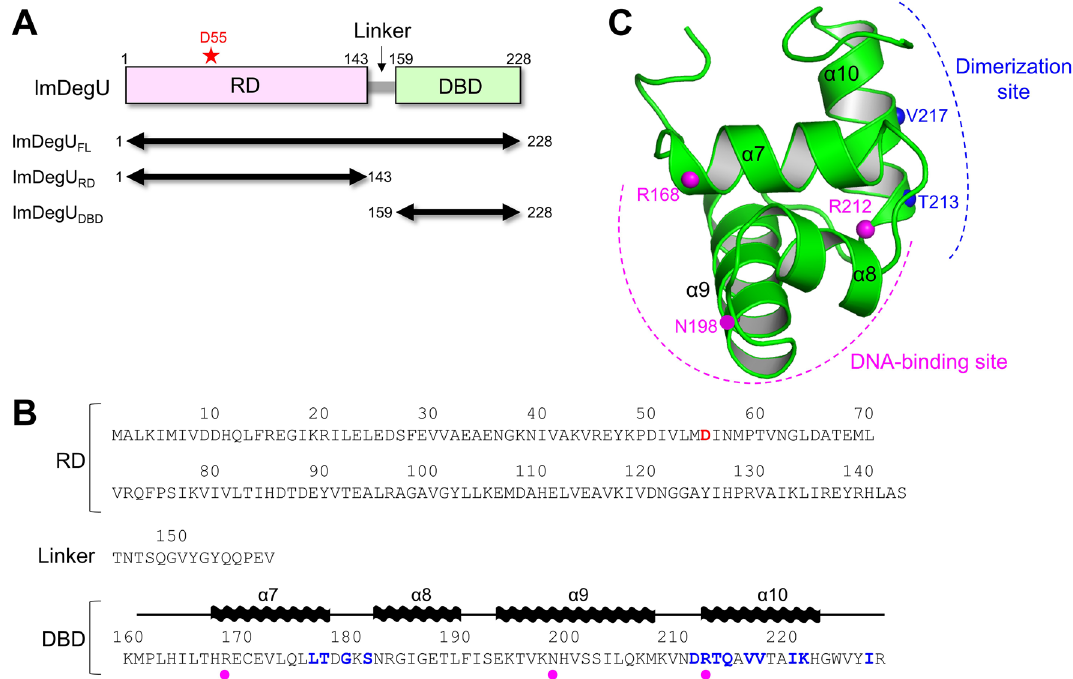
Figure 1. Domain organization of lmDegU and overall structure of lmDegU DBD . ( A ) Domain organization and expression constructs of lmDegU. The phosphorylation site of lmDegU (D55 residue) is indicated by a red star. ( B ) Amino acid sequence of lmDegU. The α-helices of the lmDegU DBD structure are represented by waves above the lmDegU sequence, and the remaining region defined in the lmDegU DBD structure is shown as lines. The phosphorylation site (D55 residue) and dimerization interface residues of lmDegU are colored red and blue, respectively. The three lmDegU residues (R168, N198, and R212), which were mutated to confirm their critical roles in dsDNA binding, are indicated by magenta circles. ( C ) Overall structure of a lmDegU DBD monomer (chain A). The lmDegU DBD structure is shown as green ribbons. The T213 and V217 residues, which were mutated to confirm the dimerization interface of lmDegU DBD , are shown as blue spheres. The R168, N198, and R212 residues of lmDegU, which were mutated to confirm their critical roles in dsDNA binding, are indicated by magenta